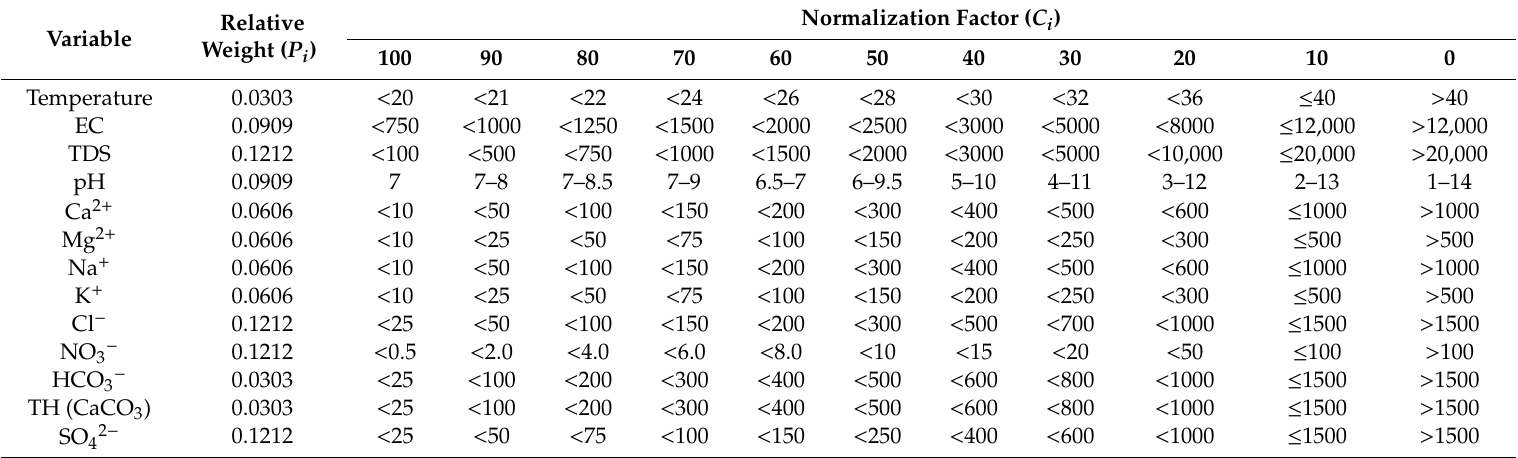
Table 2. Variables used in the water quality index (WQI) calculations, relative weights, and scores of normalization.